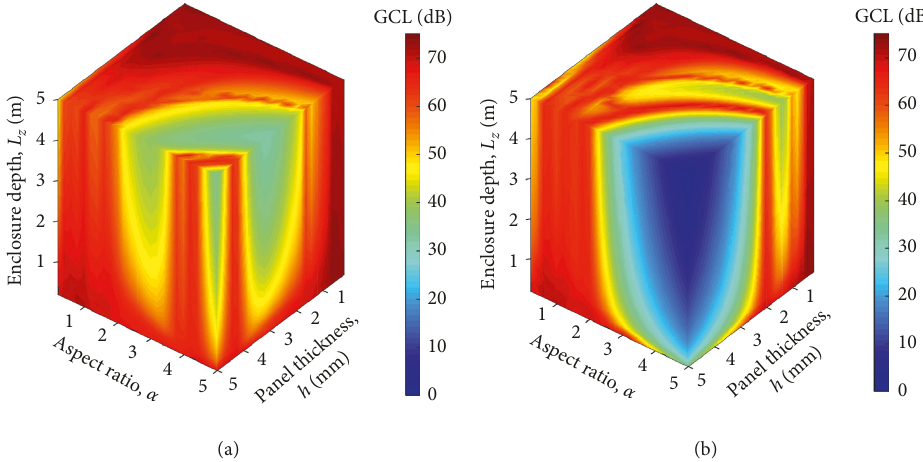
Figure 14: Comprehensive effect of structural parameters on global coupling level of the panel-enclosure system with different panel boundary conditions. (a) Simply supported panel. (b) Clamped